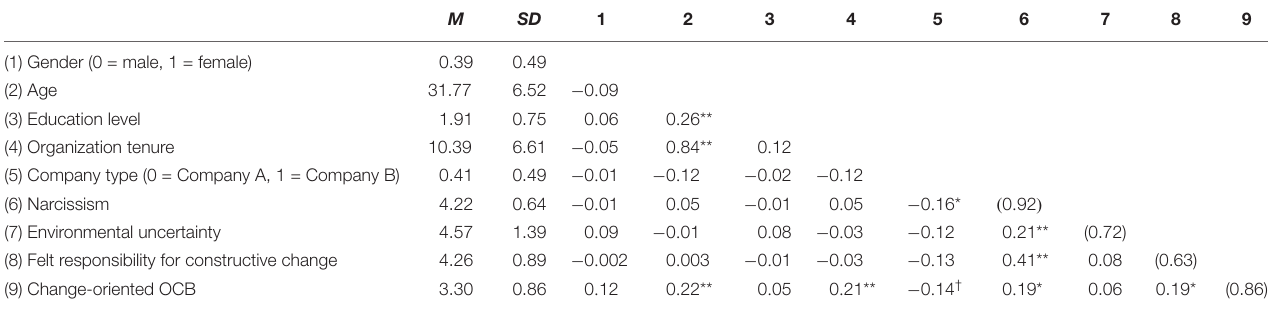
TABLE 5 | Study 2 descriptive statistics and correlation matrix.